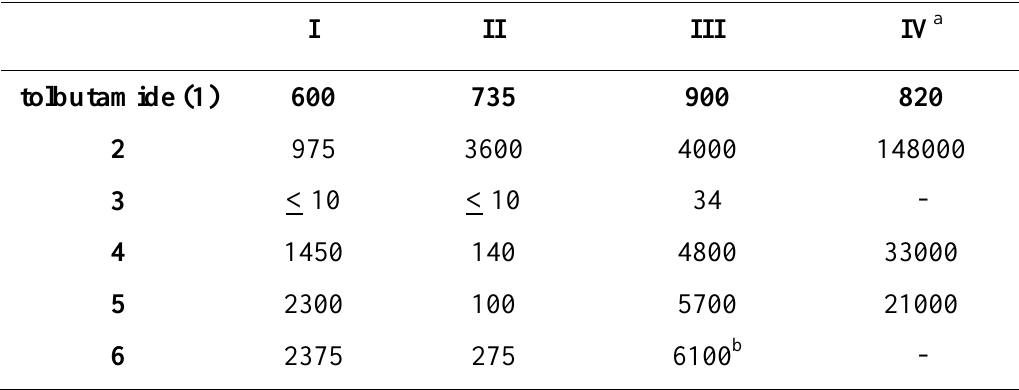
Table 1 . Experimental binding constants K